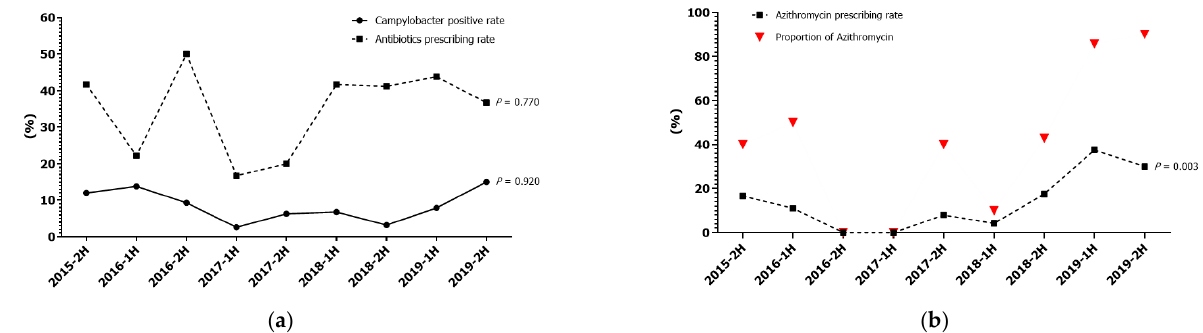
Figure 2. The trends in Campylobacter positive rates and antibiotic prescribing rates ( a ); the use of azithromycin ( b